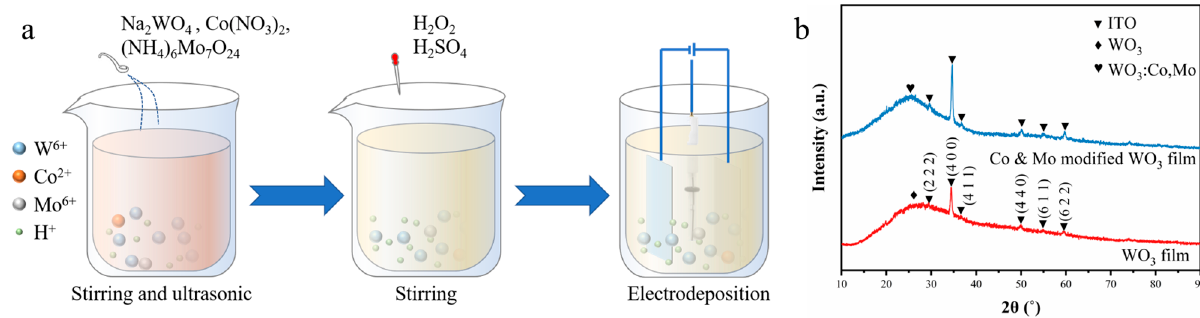
Figure 1. ( a ) Schematic illustration of the fabrication of Co and Mo co-modified WO 3 film. ( b ) XRD patterns of the prepared films.